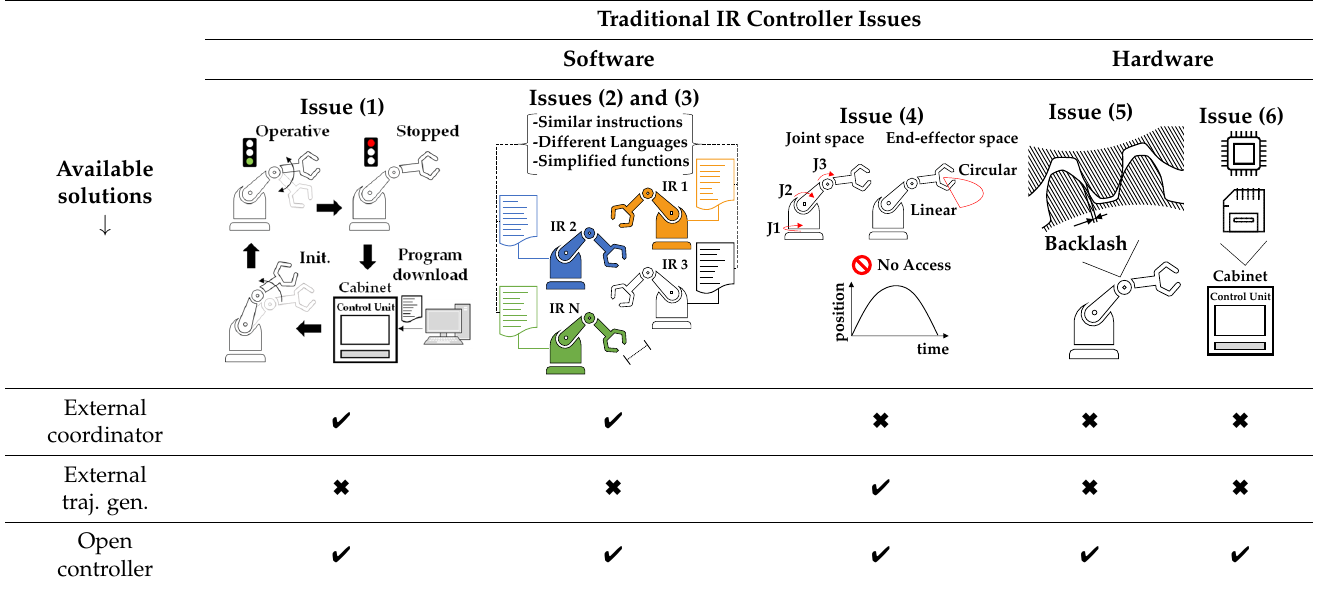
Table 1. Practical issues encountered with a traditional IR controller (numbered as in Section 3) and available solutions.